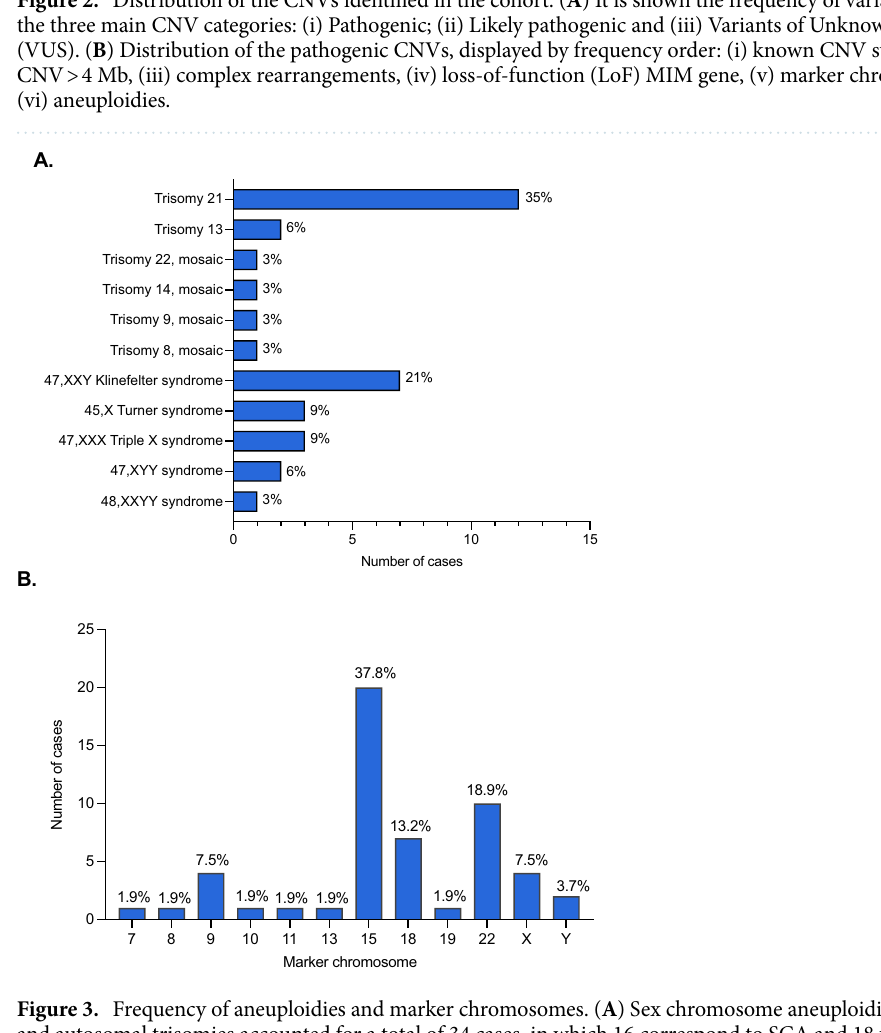
Figure 3. Frequency of aneuploidies and marker chromosomes. ( A ) Sex chromosome aneuploidies (SCA) and autosomal trisomies accounted for a total of 34 cases, in which 16 correspond to SCA and 18 to autosomal trisomies. The histogram shows the frequency of aneuploidies for each chromosome. ( B ) The frequency of the detected 53 marker chromosomes is displayed according to its chromosome